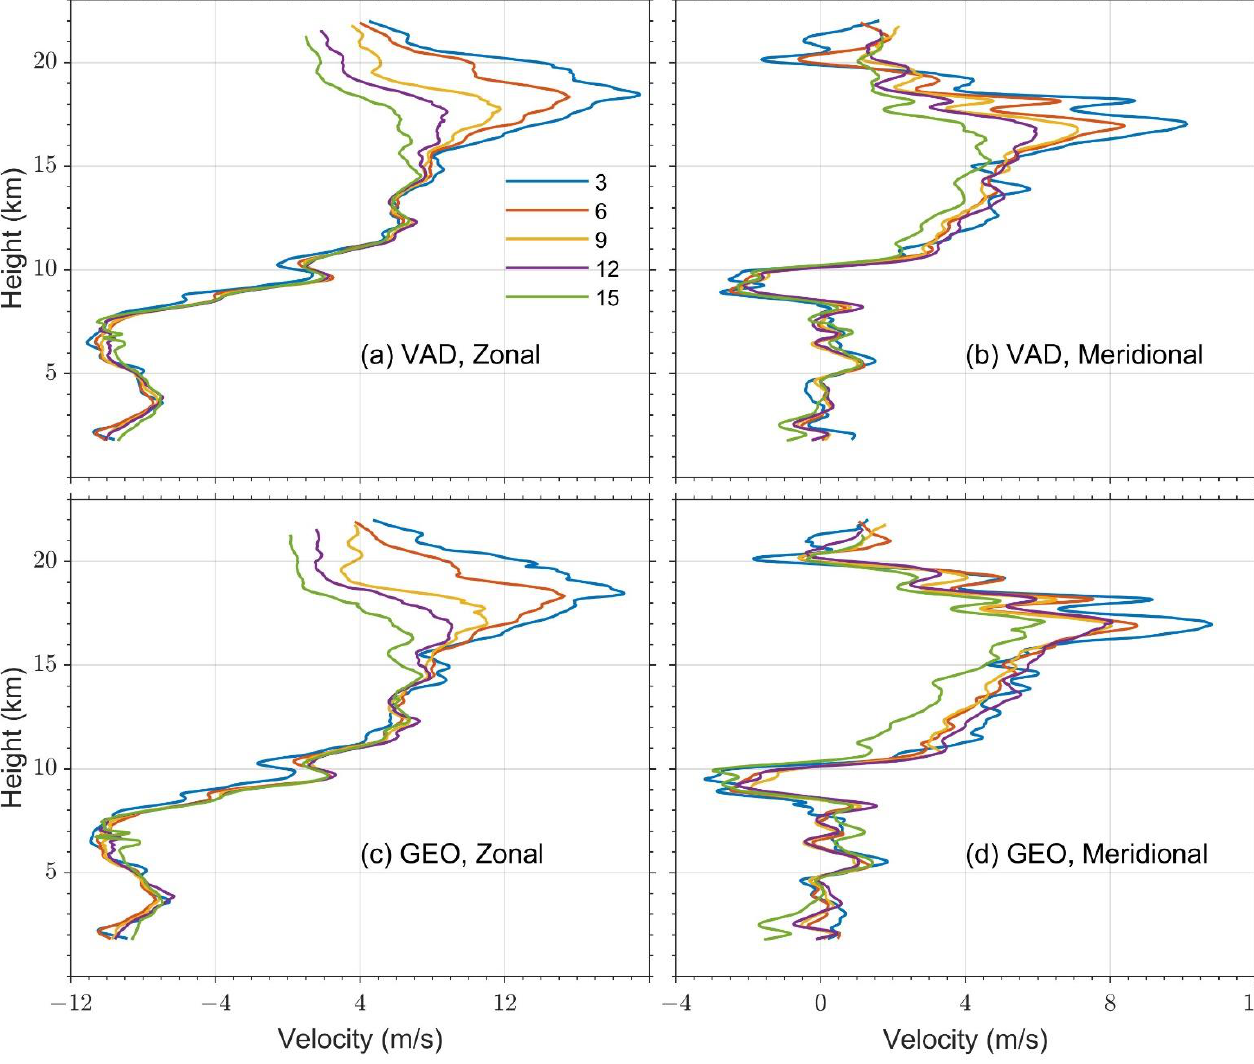
Figure 6. Daily mean height distributions of zonal wind ( a , c ) and meridional wind ( b , d ) derived from the VAD ( a , b ) and GEO ( c , d ) methods for different zenith angles from 3° to 15° with increments of 3° (distinguished by colors) on 21 July 2021, in experiment #3.